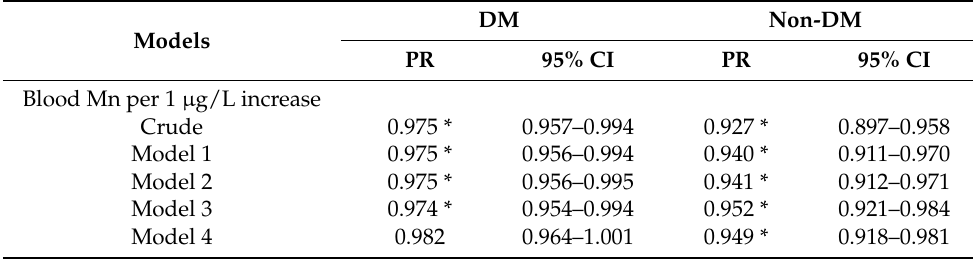
Table 5. Poisson regression analysis with robust variance for anemia in subgroups according to